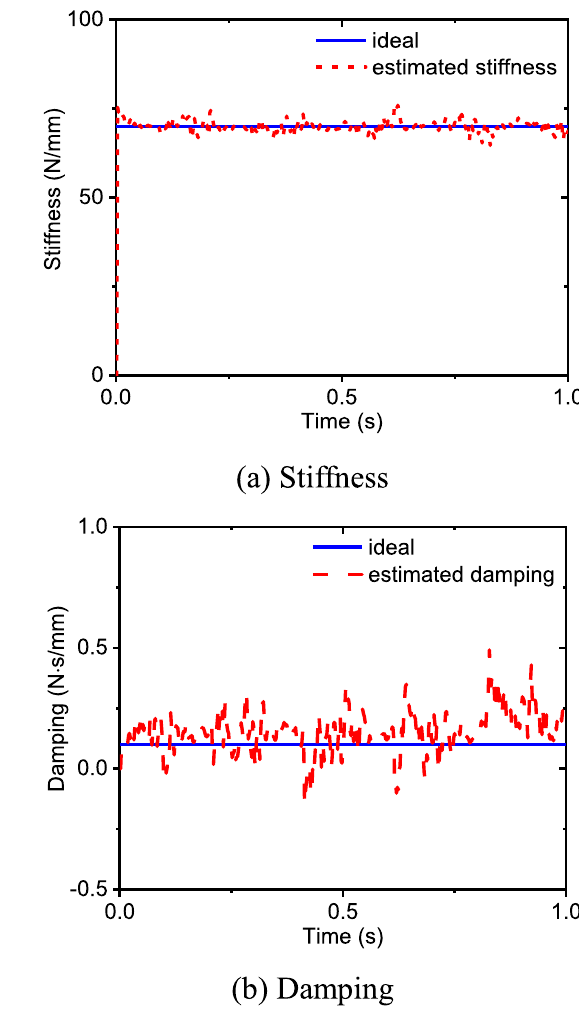
Figure 8 Estimated contact parameters in virtual wall